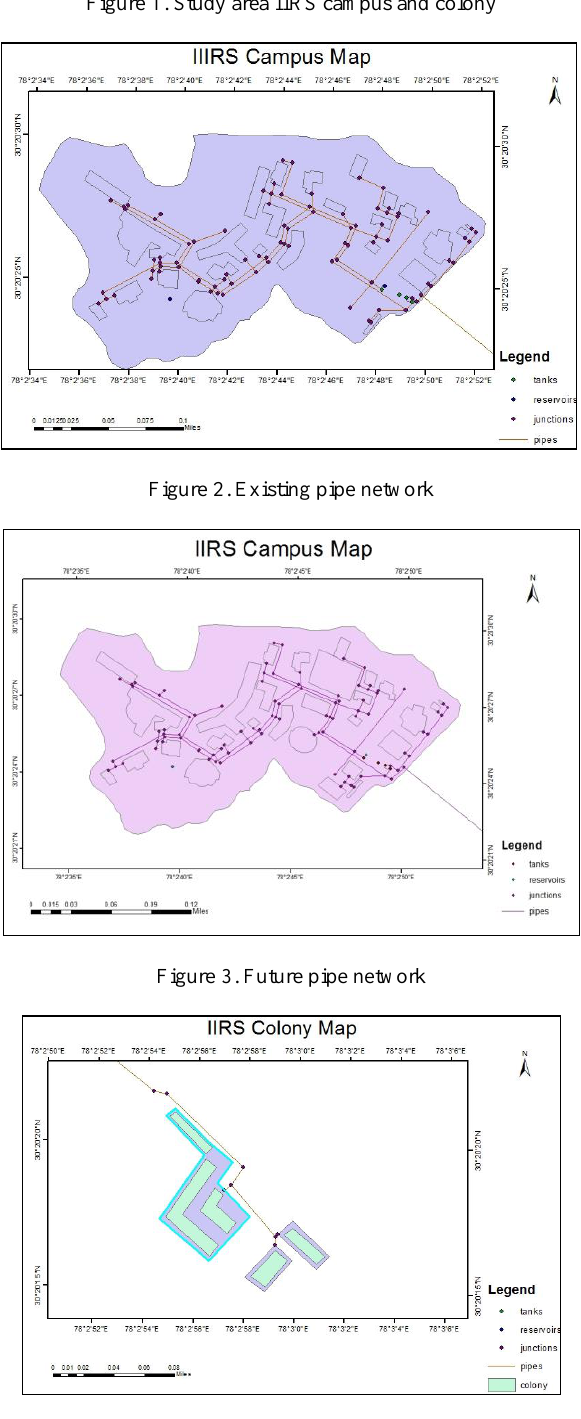
Figure 4. Colony of IIRS employees